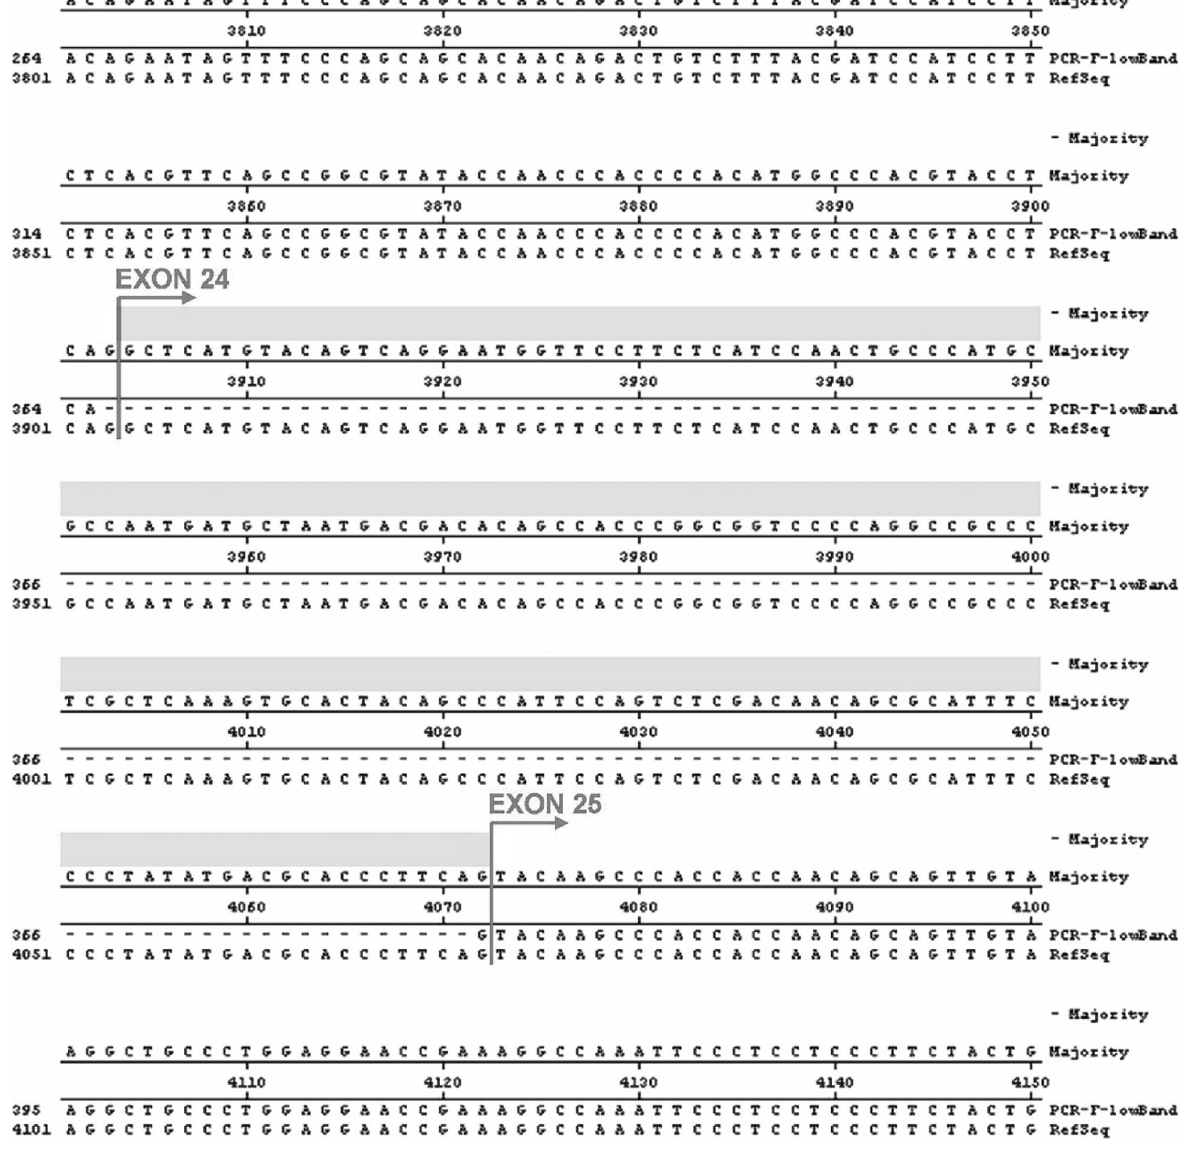
Fig. 4 Alignment of the published human ataxin-2 cDNA sequence with the sequence from the lower band of RT-PCR product F. Exon 24 was